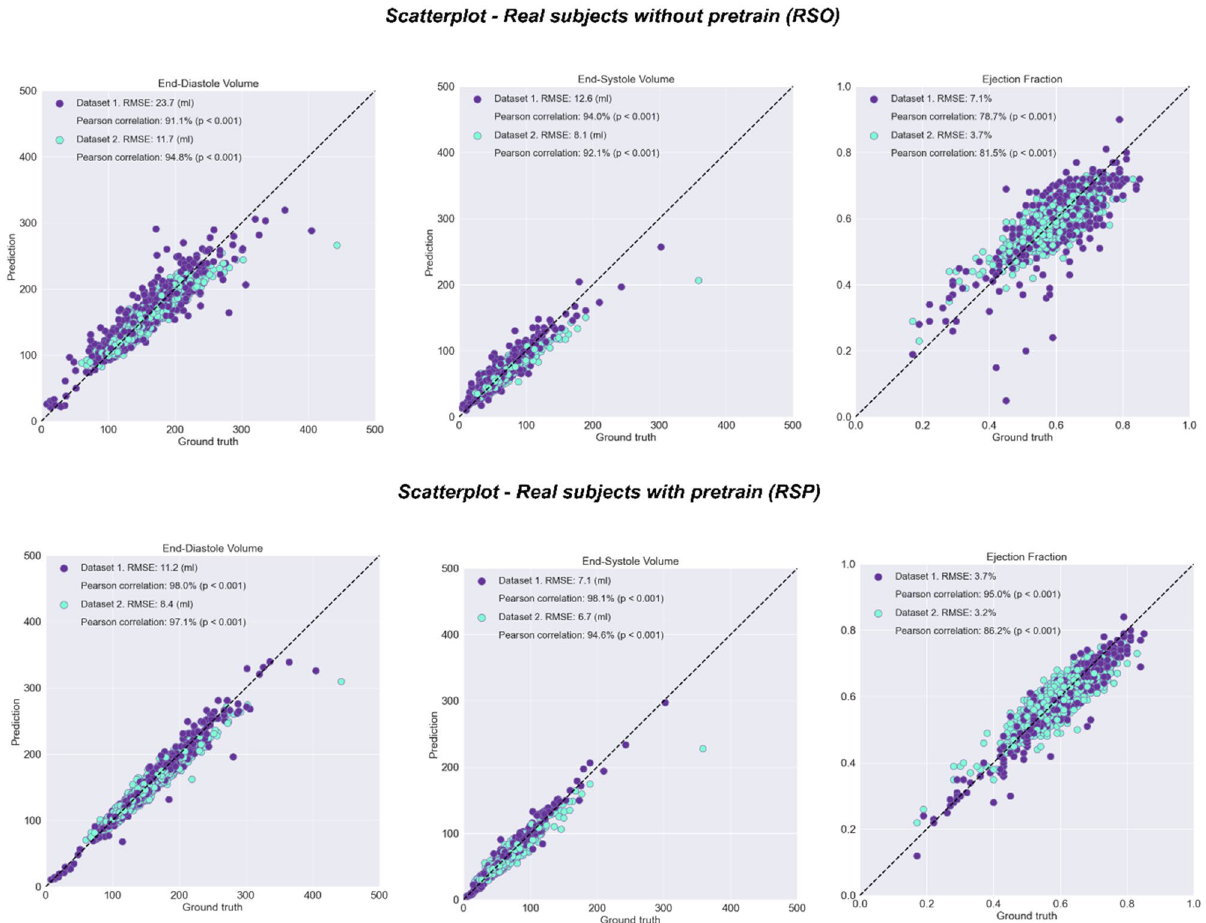
Figure 4. Scatter plots of predicted and ground truth volumes and EF on the Dataset 1 test dataset (purple) and Dataset 2 test dataset (light blue), for the model trained on real cases only, without pretraining (RSO) and the model finetuned on real cases after pretraining on synthetic data (RSP). RMS Error is computed for EDV, ESV and ejection